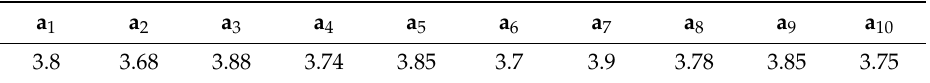
Table 3. Measurement of light-section microscope (unit: mm).